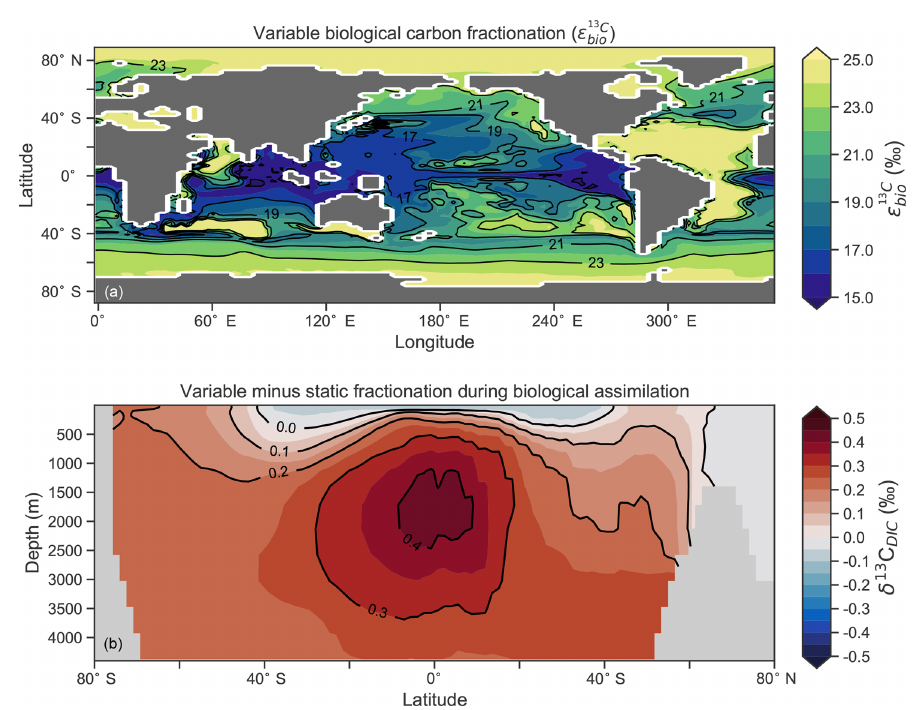
Figure 4. The introduction of variable carbon fractionation by phytoplankton (a) and the consequent change in δ 13 C DIC represented as a zonal mean (b) relative to a case where (cid:15) 13 C is fixed at bio